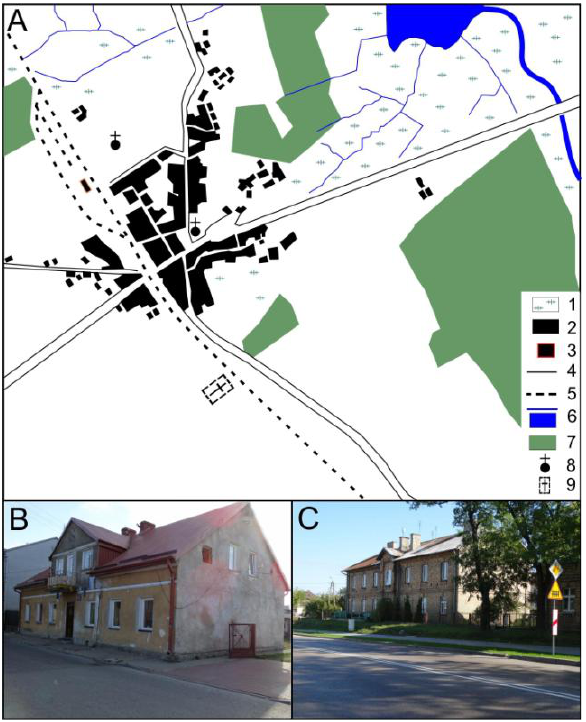
Fig. 1. Spatial layout of Grajewo in the beginning of the 20 th century (A) and buildings alongside the railway line (B-C) (Source: author’s own study based on Новая Топографическая Карта…, 1916 (A); photo by author (B-C)